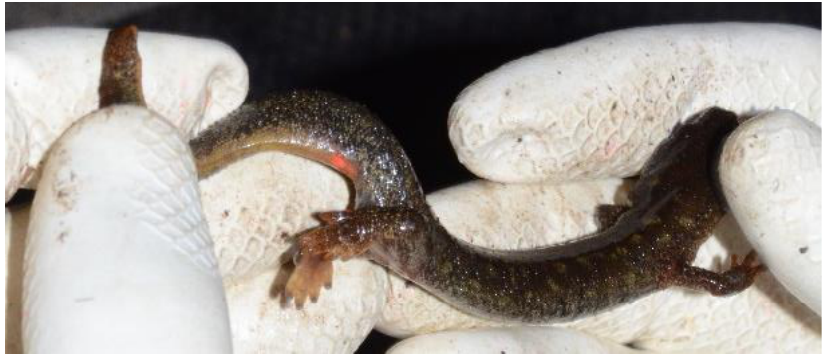
Figure 5. Marked individual with elastomer in caudal area.